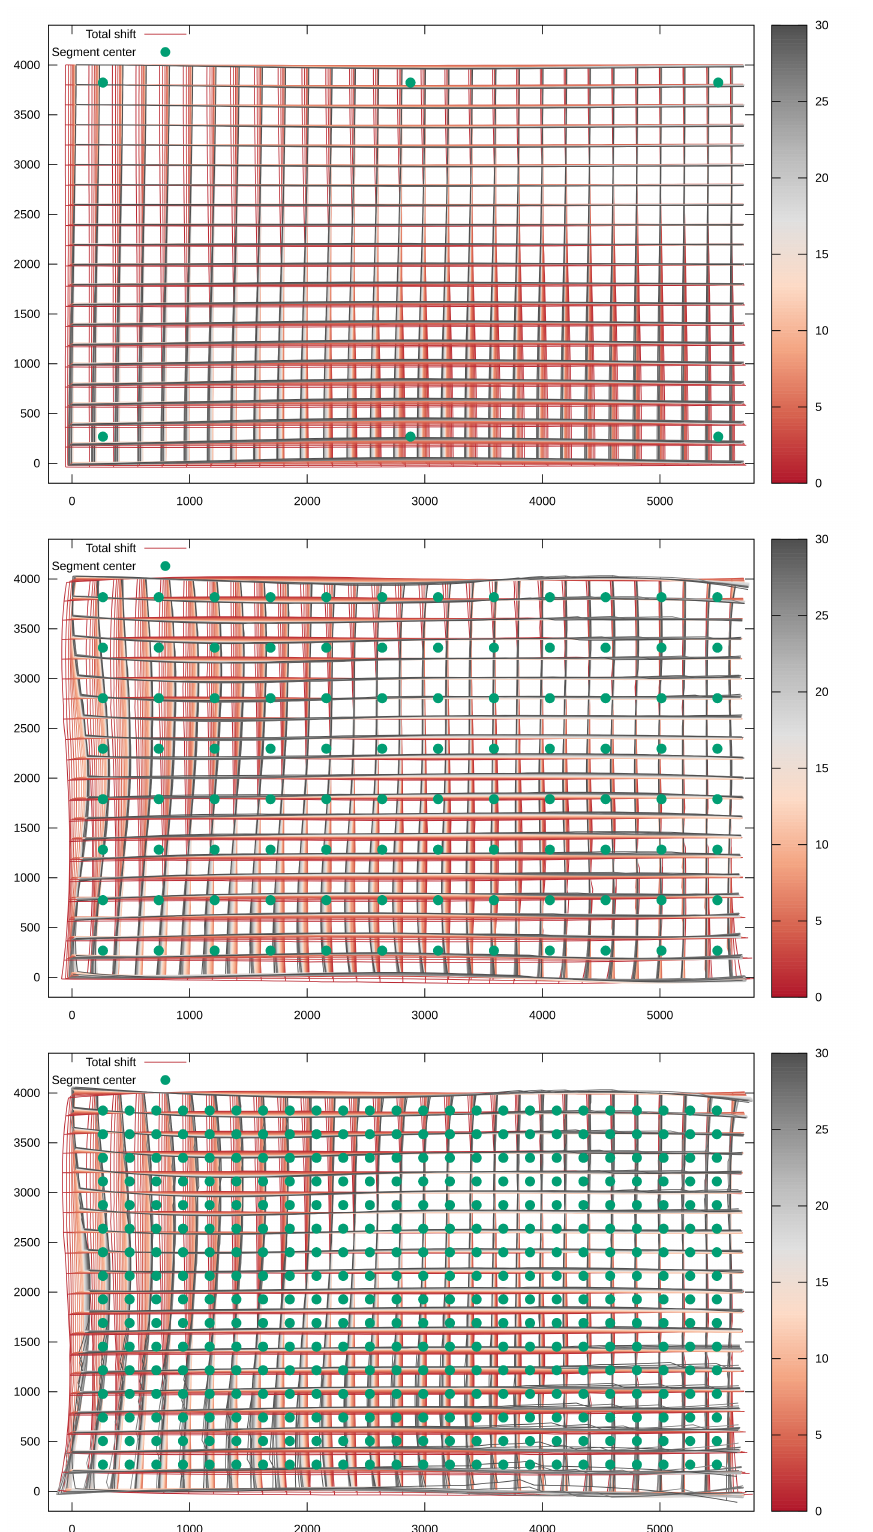
Figure 17. Influence on shift estimation using a different number of patches: 3 × 2 ( top ), 12 × 8 ( middle , default value), 24 × 16 ( bottom